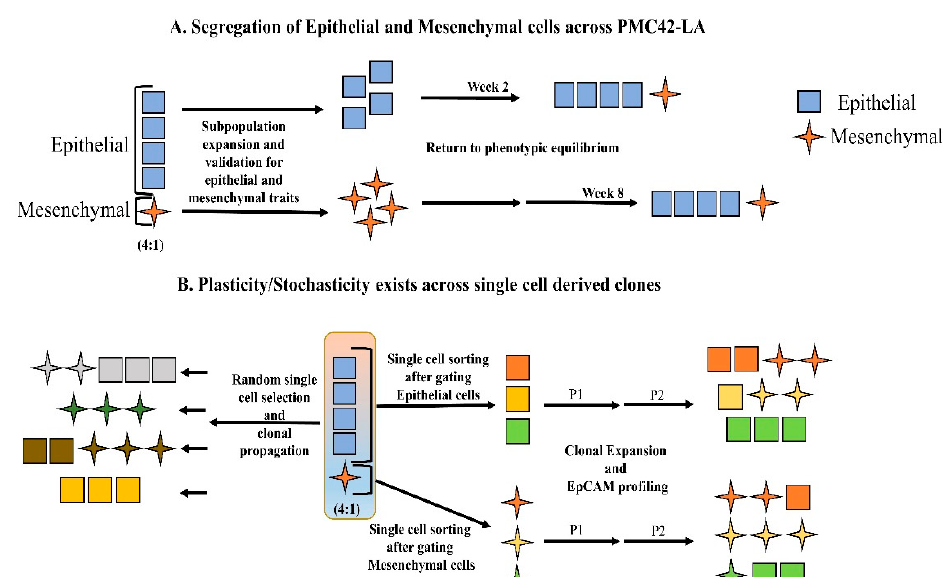
Figure 3. ( A ) Schematic depicting the results of phenotypic equilibrium achieved across sorted and passaged EpCAM subpopulations. ( B ) FACS based single cell sorting and clonal propagation to examine the proportion of epithelial and mesenchymal cells using EpCAM profiling. Single cells were randomly selected across the whole cell population, as well as after gating for epithelial and mesenchymal selection, and seeded in 96-well plates. The progeny of the cells were EpCAM profiled after Passage 2 to identify variation across phenotypic plasticity.